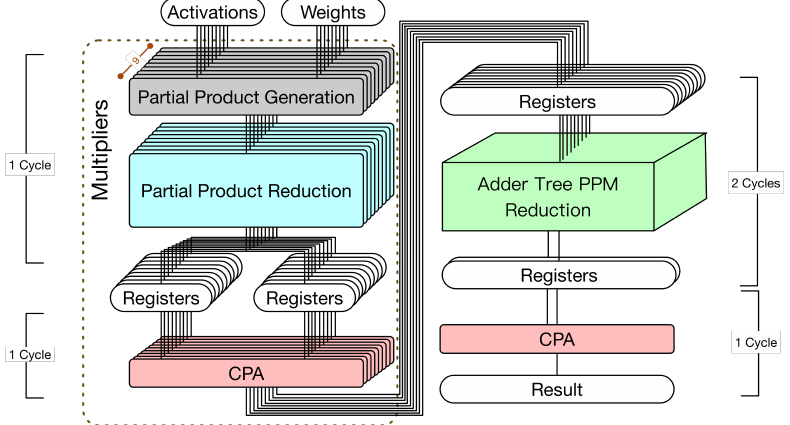
Figure 4. The state-of-the-art approach [24] (i.e., the hardware 3 × 3 convolver that treats the adder tree as a